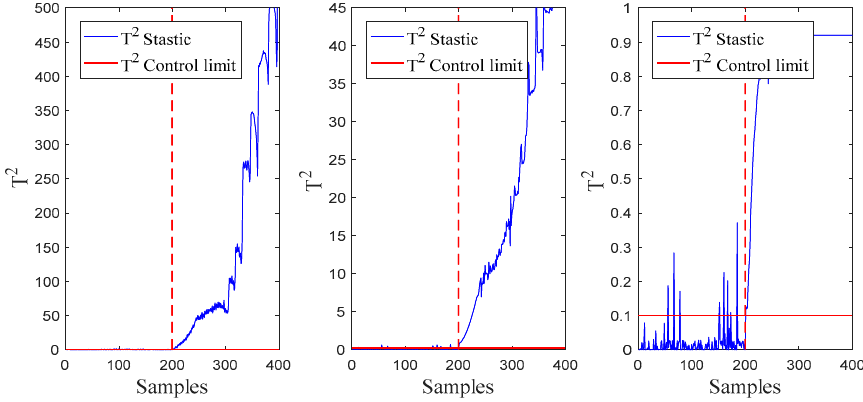
Figure 10. Monitoring results of fault 3.